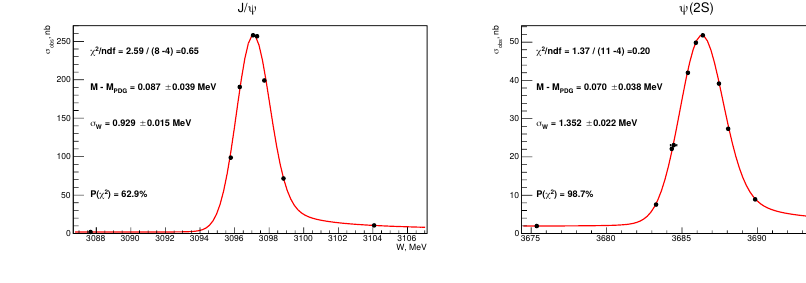
Figure 2. The result of scans of ψ resonances.